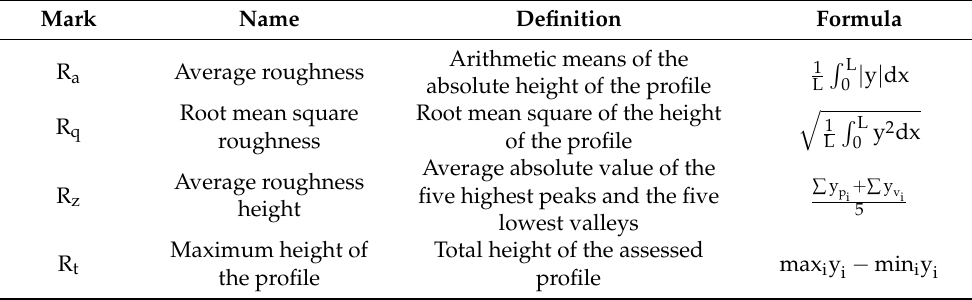
Table 3. The examined surface-roughness parameters.